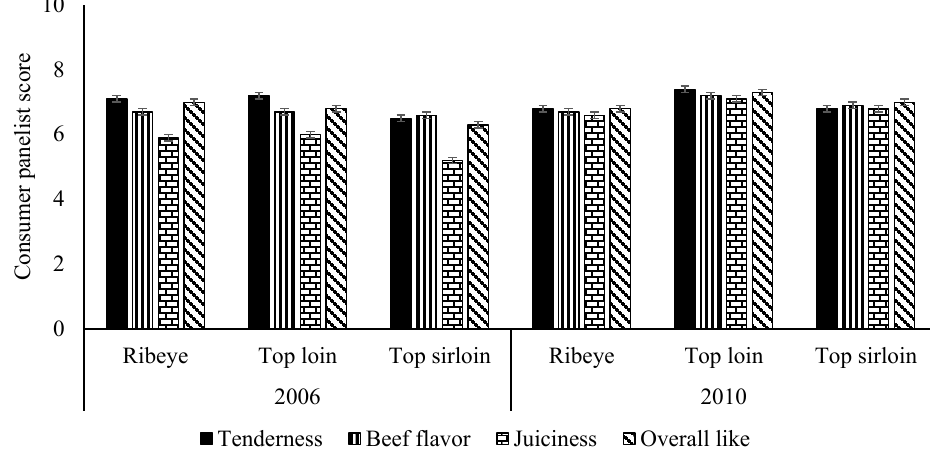
Figure 3. Consumer panel evaluations of tenderness, beef flavor, juiciness, and overall like for rib and loin steaks evaluated during the 2006 and 2010 National Beef Tenderness Surveys. 10 = very tender, extreme amount, very juicy, and like extremely; 1 = not at all tender, none at all, not at all juicy, and dislike extremely. Adapted from Voges et al [12] and Guelker et al [13].